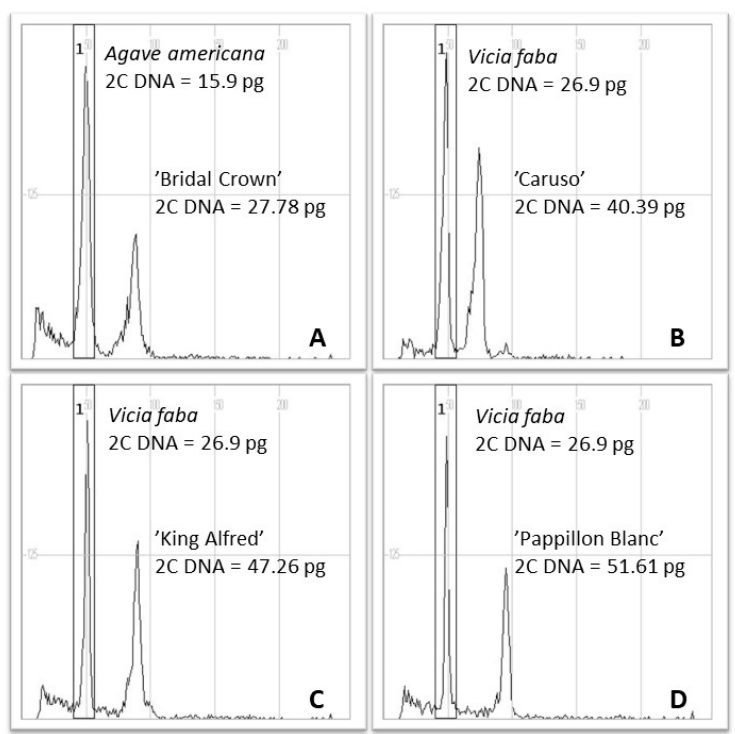
Figure 2. Histograms of flow cytometry of selected Narcissus genotypes: ( A ) cultivar ‘Bridal Crown’, assumed to be diploid; ( B ) ‘Caruso’, assumed to be triploid; and ( C ) ‘King Alfred’ and ( D ) ‘Pappillon Blanc’, assumed to be tetraploids.